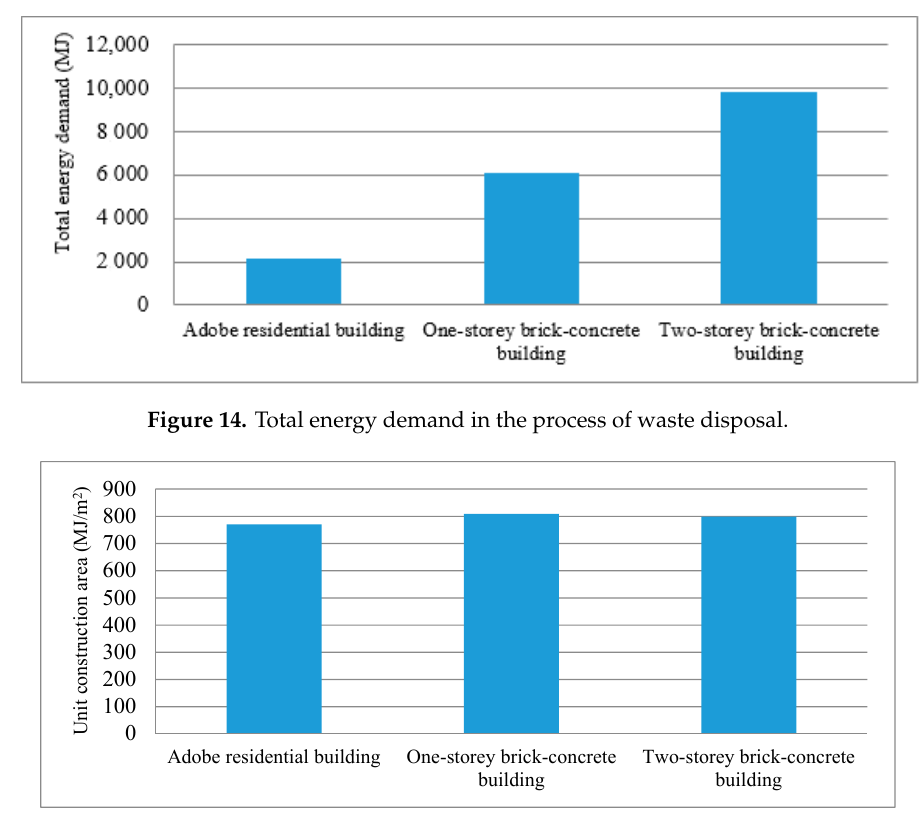
Figure 15. Energy demand of unit construction area in the process of waste disposal.